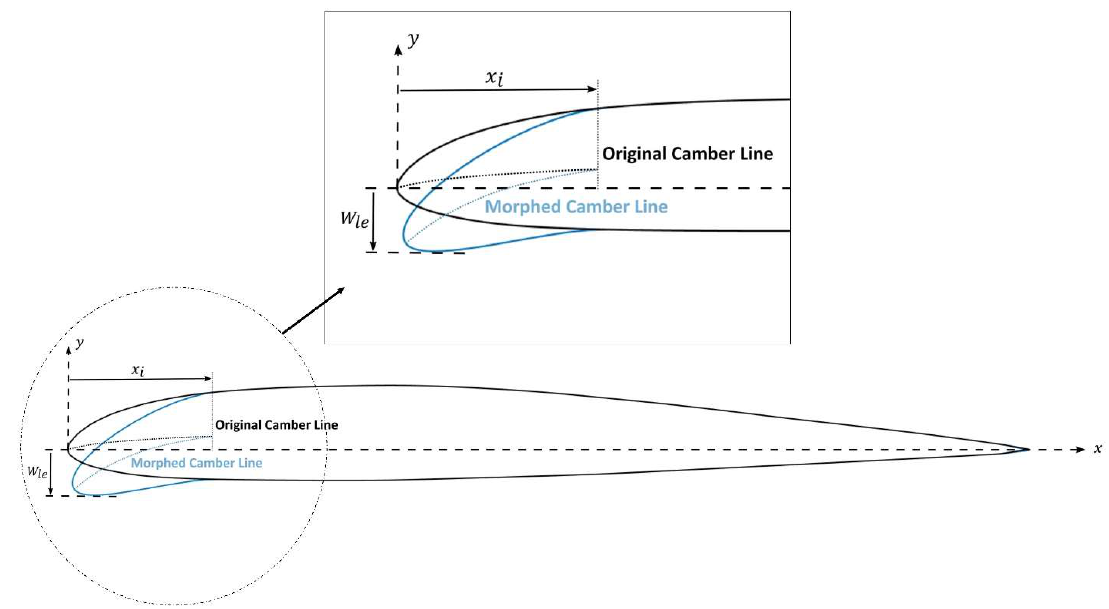
Figure 1. Geometrical definition of a variable camber line.